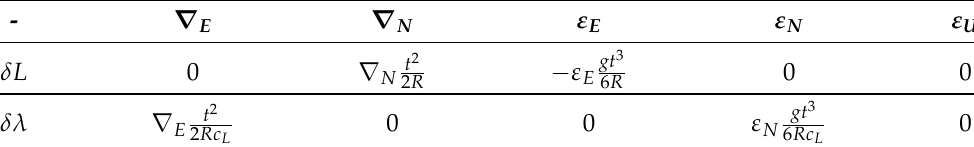
Table 2. Short-term navigation error